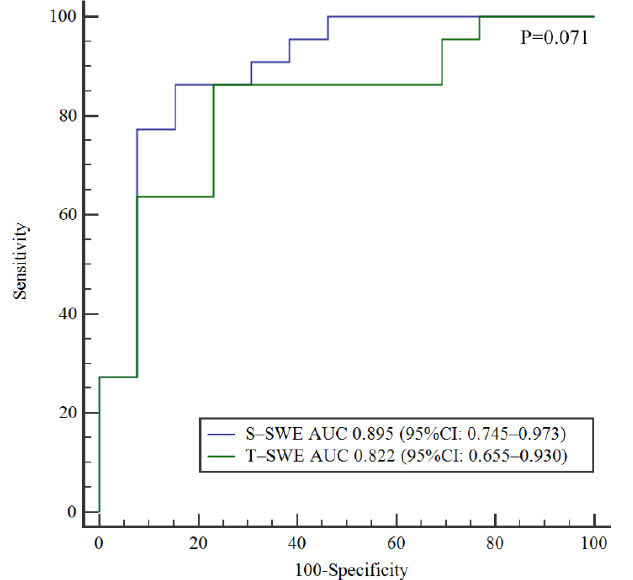
Figure 4. Comparison of ROC curves for Toshiba shear wave elastography and Supersonic shear wave elastography in the identification of biliary atresia.